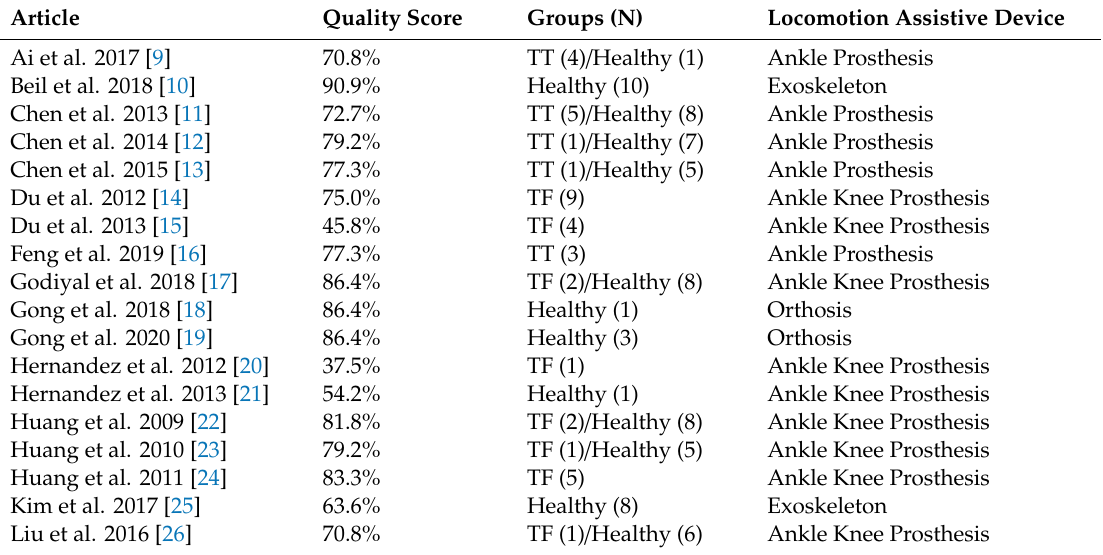
Table 1. Quality assessment and recruited volunteers in the included studies.